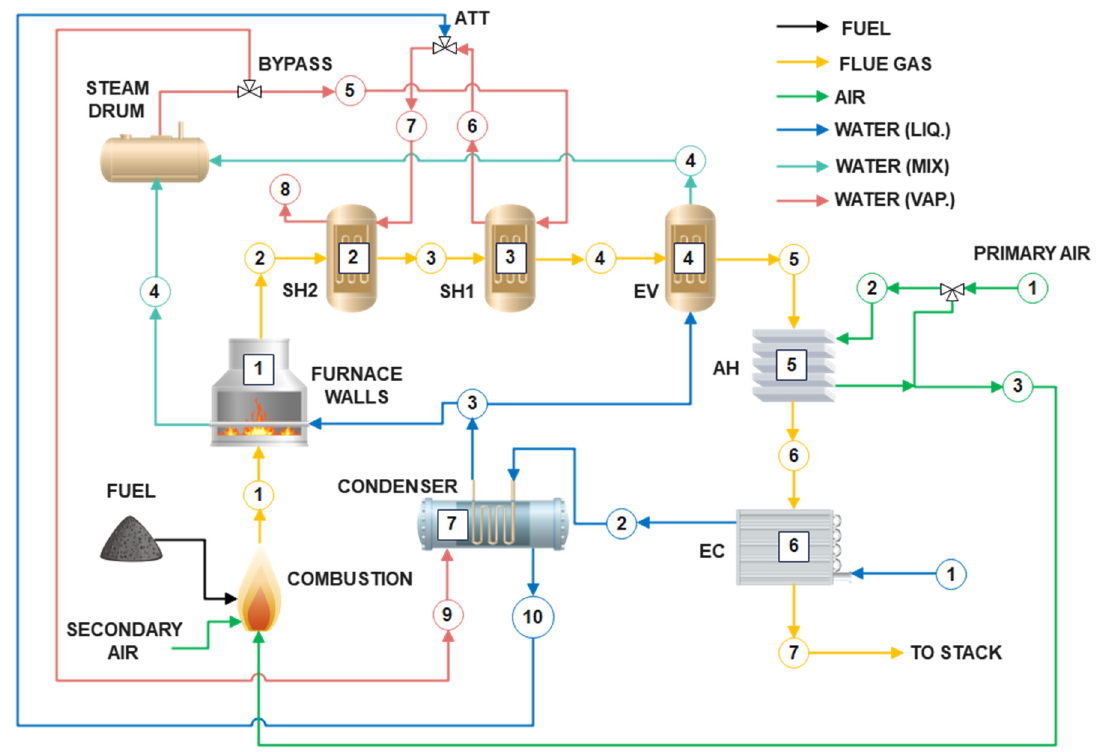
Figure 11. Process flow diagram of industrial-scale biomass-fired boiler model.